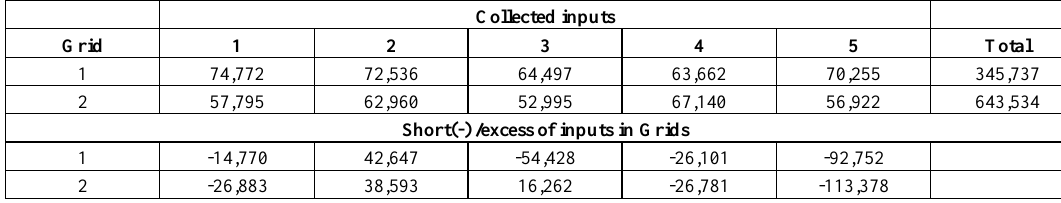
Table 4. Model estimate for the amount of inputs collected by the typical grids Collected